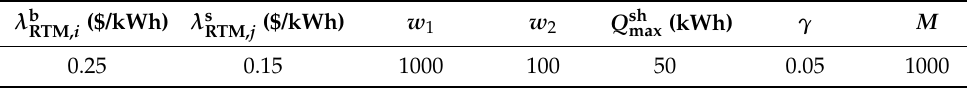
Table 1. Constant parameters used in the